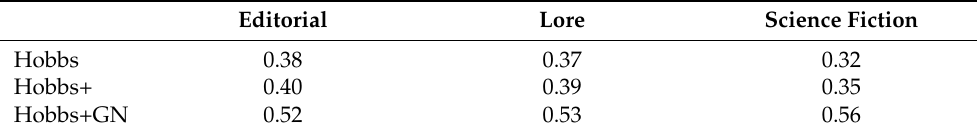
Table 4. Comparison of Hobbs’ original algorithm to our improvements (Hobbs’ metric).